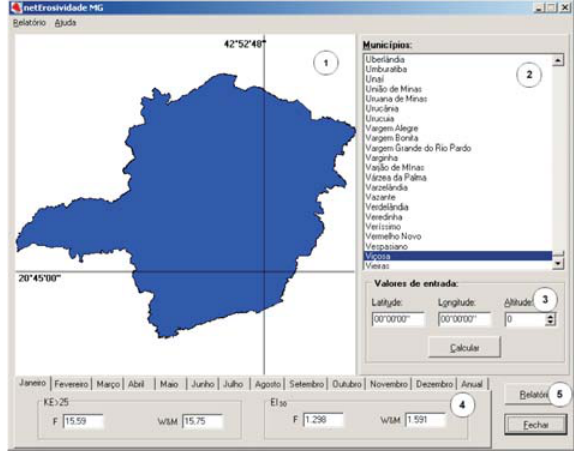
Figura 3. Tela principal do NetErosividade MG .